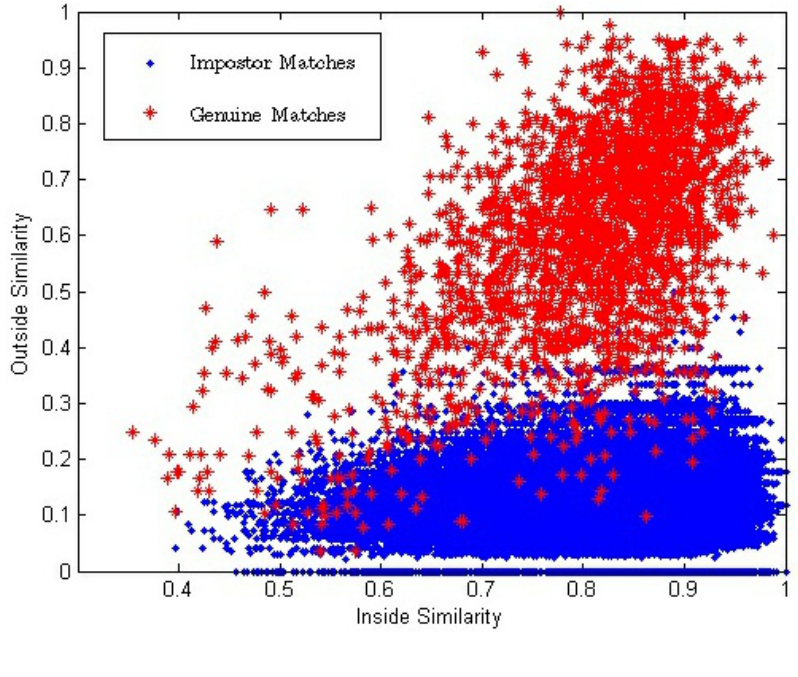
Two-dimensional distributions of ( S I , S O ) for all the genuine and impostor